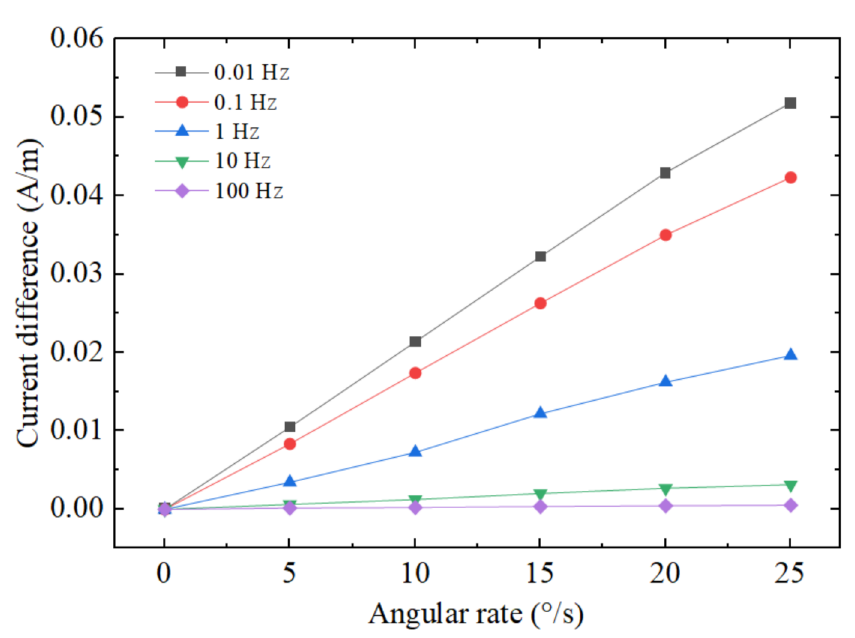
Figure 7. The output linearity curves at different